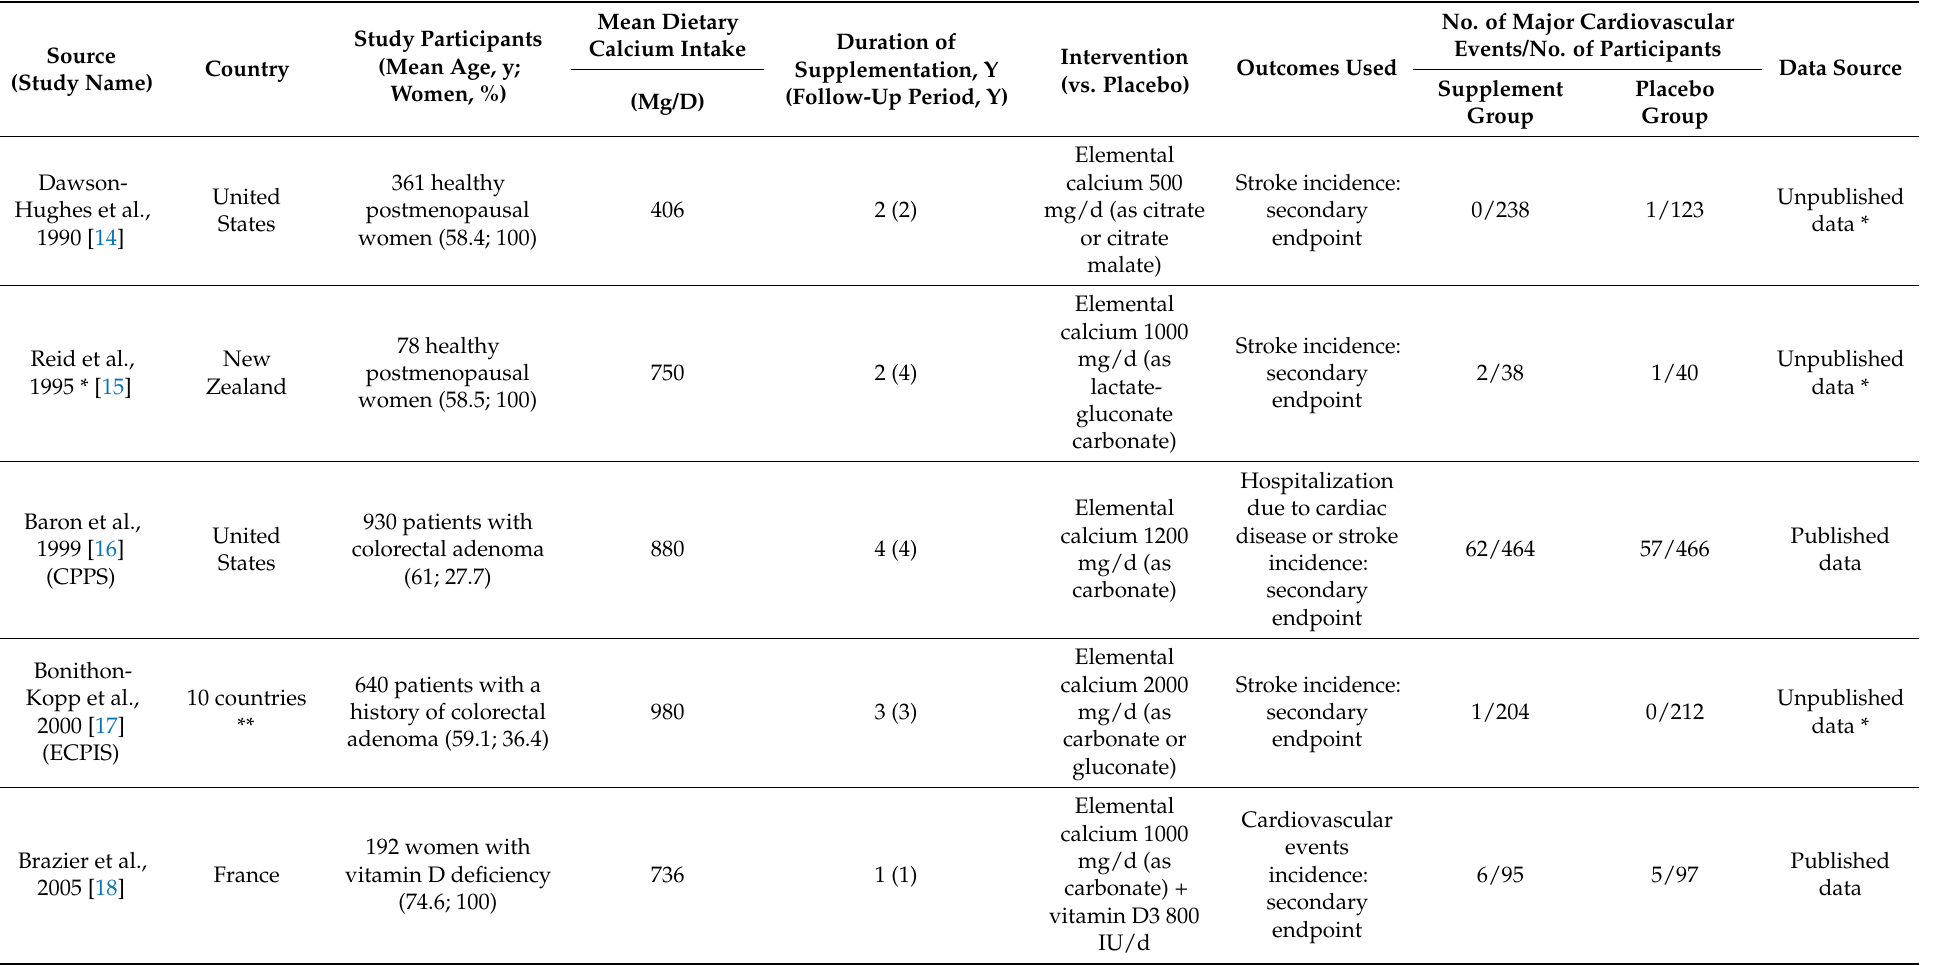
Table 1. General characteristics of randomized, double-blind, placebo-controlled trials included in final analysis (n =